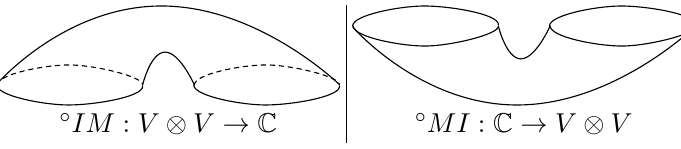
Figure 25 . The basic building blocks of a 2d TFT.